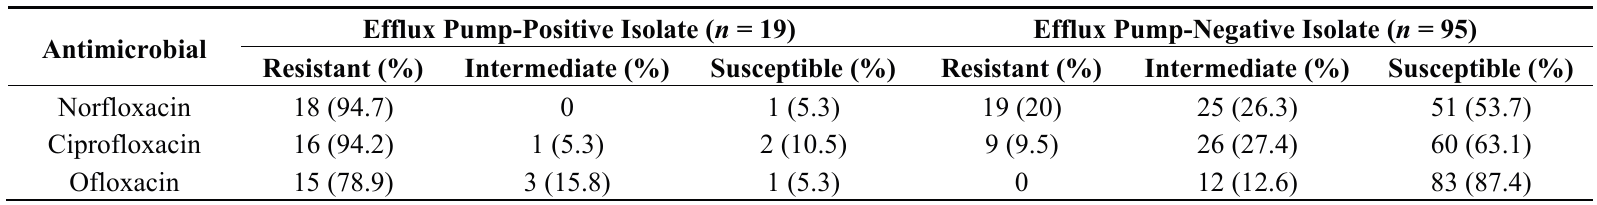
Table 6. Effect of reserpine treatment on the susceptibility of 114 Stenotrophomonas maltophilia isolates to 3 fluoroquinolone antimicrobials. No. Resistant Percentage of No. Intermediate Percentage of No. Susceptible Percentage of Antimicrobial MIC R ( µ g/mL) Isolate Resistant Isolate (%) Isolate Intermediate Isolate (%) Isolate Susceptible Isolate (%) Norfloxacin 0.5–128 Norfloxacin +reserpine Ciprofloxacin Ciprofloxacin + reserpine Ofloxacin 0.125–64 Ofloxacin + reserpine Table 7. Comparison of fluoroquinolone drug resistance phenotype between efflux pump-positive and -negative isolates of Stenotrophomonas maltophilia . Efflux Pump-Positive Isolate ( n = Antimicrobial